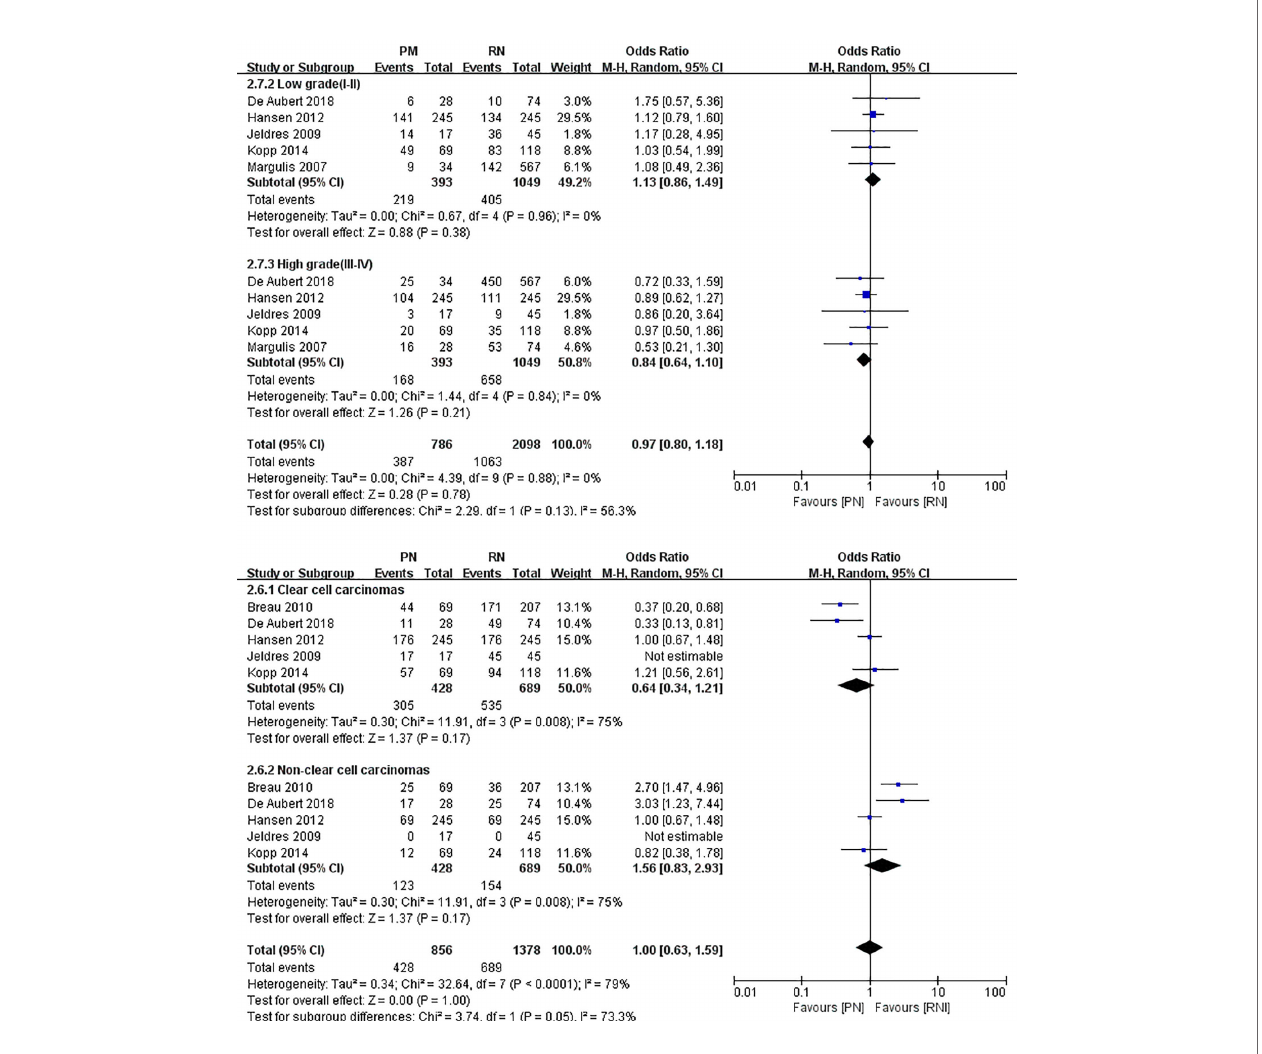
FIGURE 15 | Subgroup analysis of Fuhrman Grade and cancer